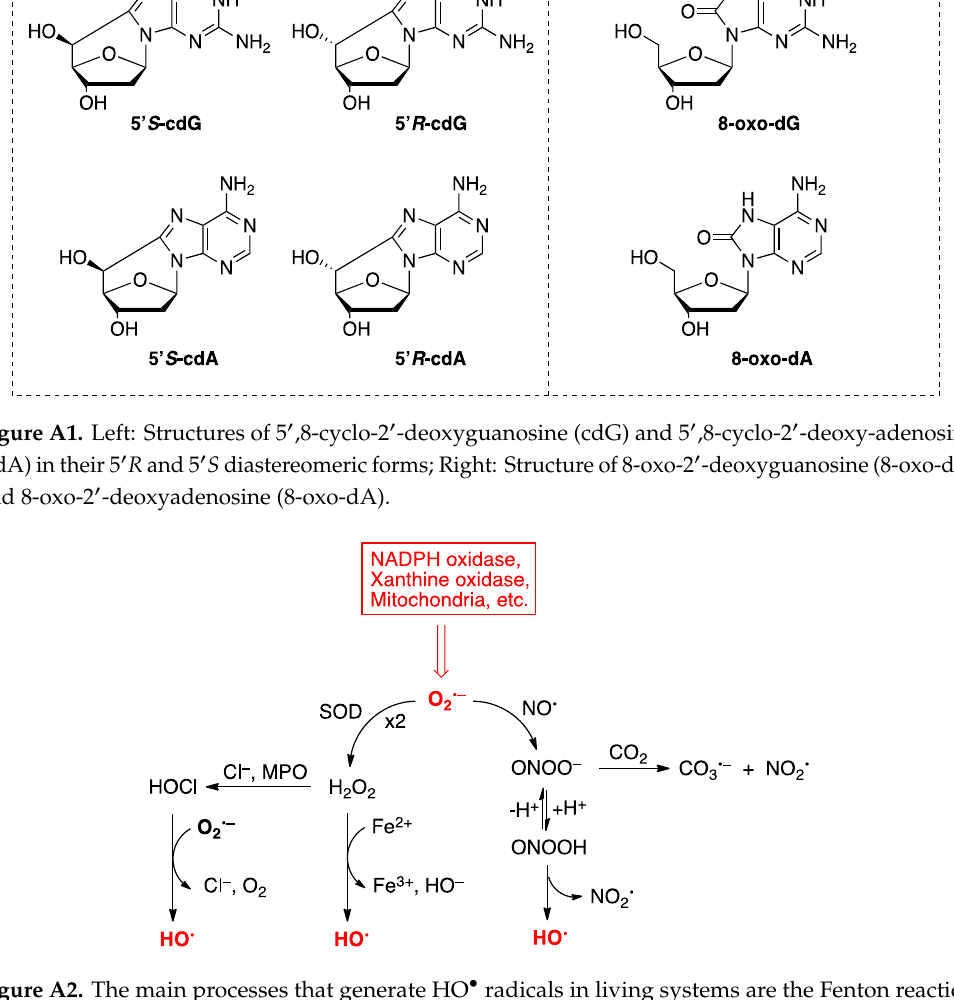
Figure A2. The main processes that generate HO • radicals in living systems are the Fenton reaction of H 2 O 2 , the reduction in HOCl by superoxide radical anion (MPO = myeloperoxidase) and the spontaneous decomposition of protonated ONOO − , respectively.